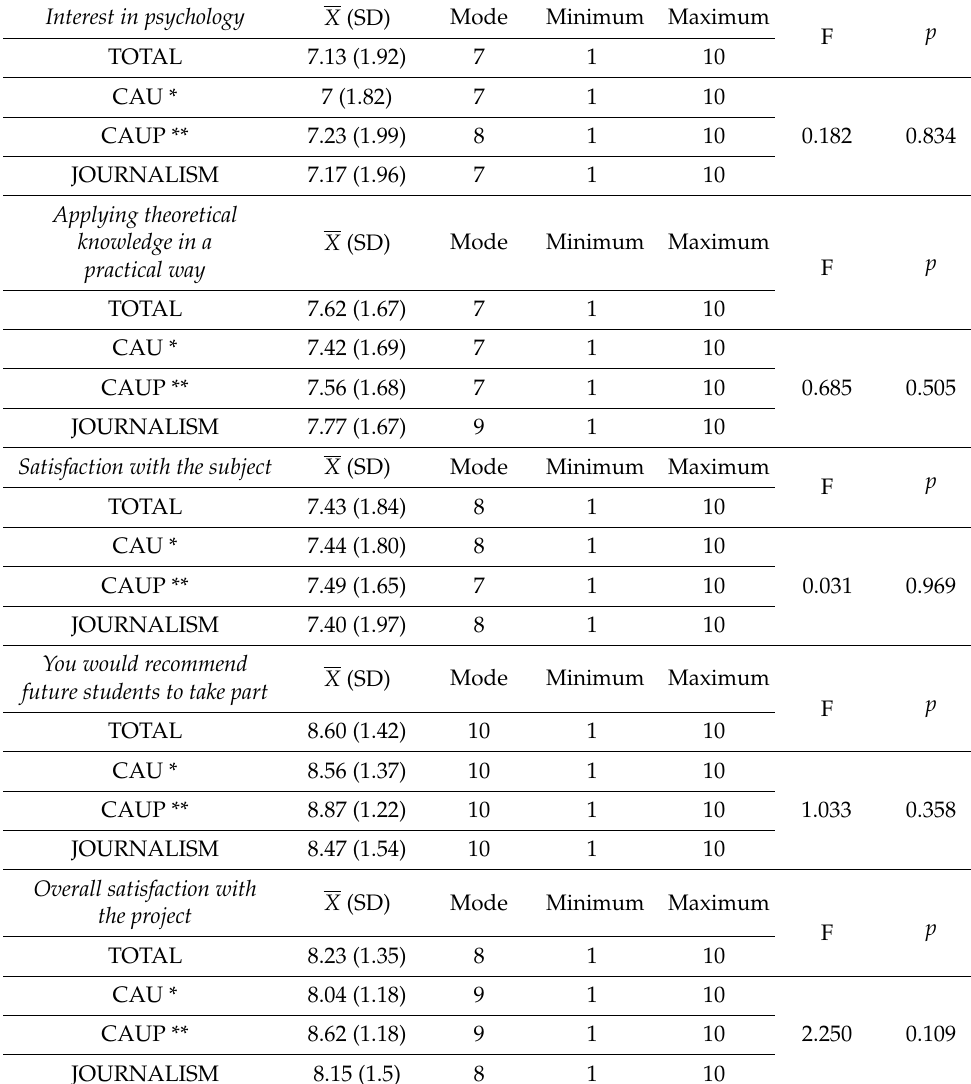
Table 3. Descriptions of the items of the satisfaction scale and ANOVA